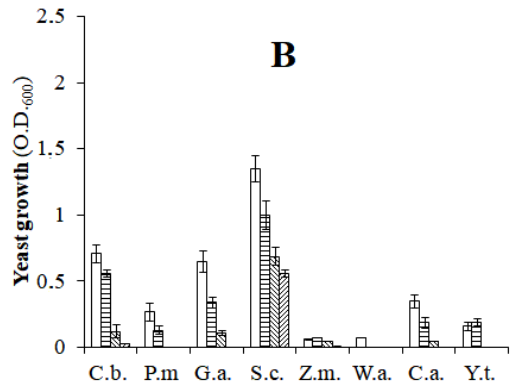
Figure 4. Oleuropeinolytic yeast growth in aerobiosis ( A ) and slightly pressurized CO 2 ( B ) conditions in the presence of 0 (